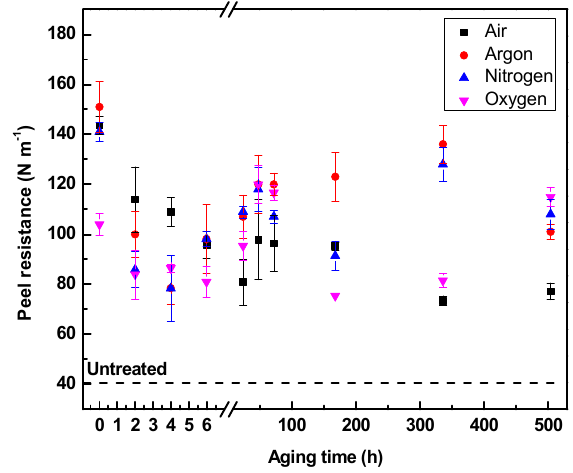
Figure 11. Peel resistance of LDPE treated for 120 s using different gases and stored in water.